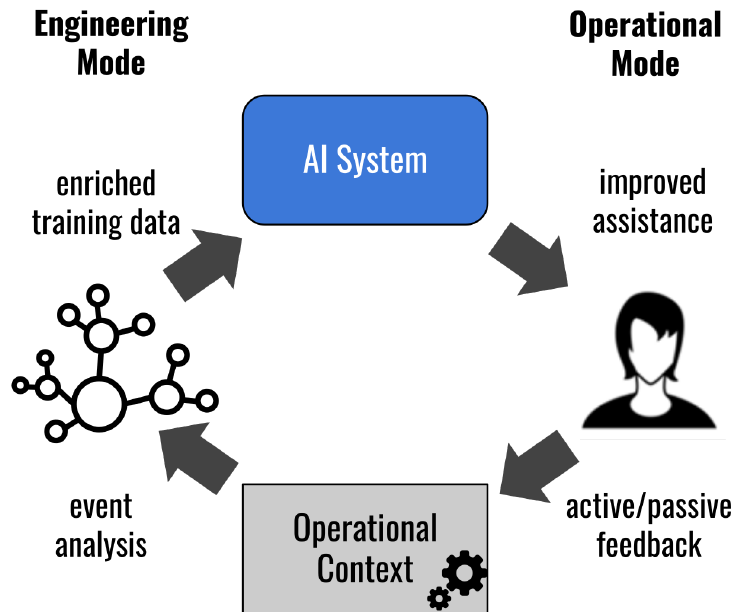
Figure 10. A knowledge-graph approach to enhance vector-based machine learning in order to sup- port human AI teaming by taking context and process knowledge into account. A knowledge graph is used as an intermediate representation of data enriched with static and dynamic context